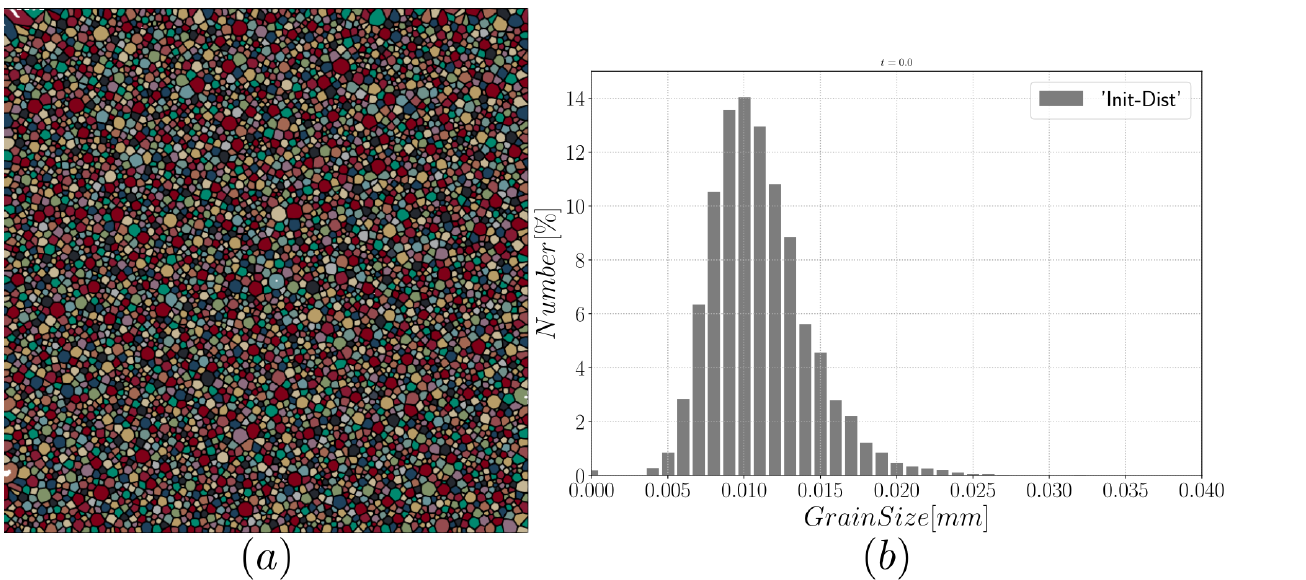
(cid:113) + φ 2 + ϕ 2 ϕ 2 , 2 1